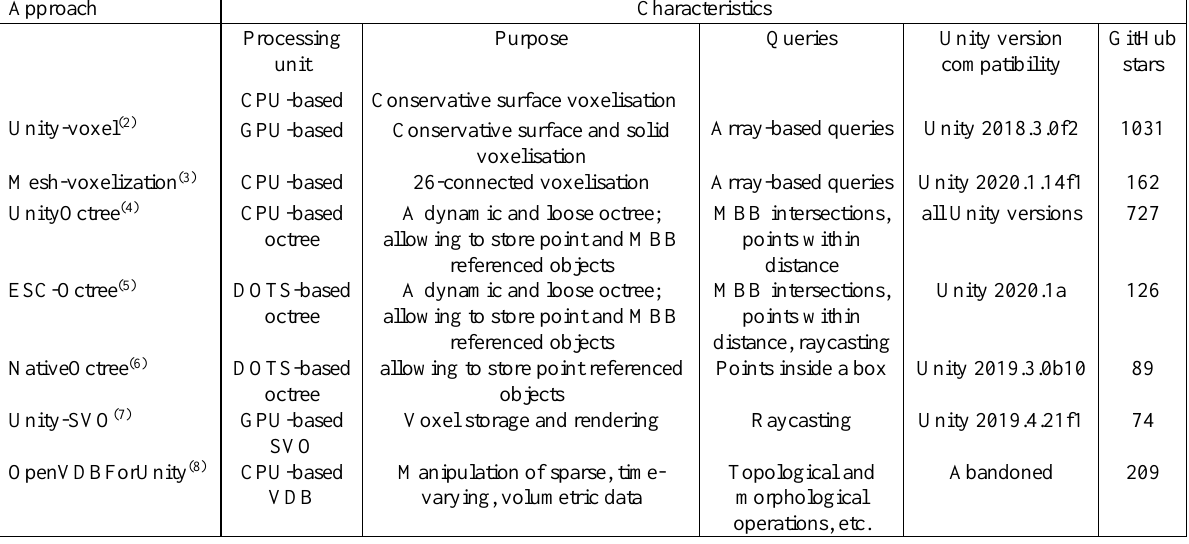
Table 2 . Voxelisation approaches and voxel data structures supported in Unity